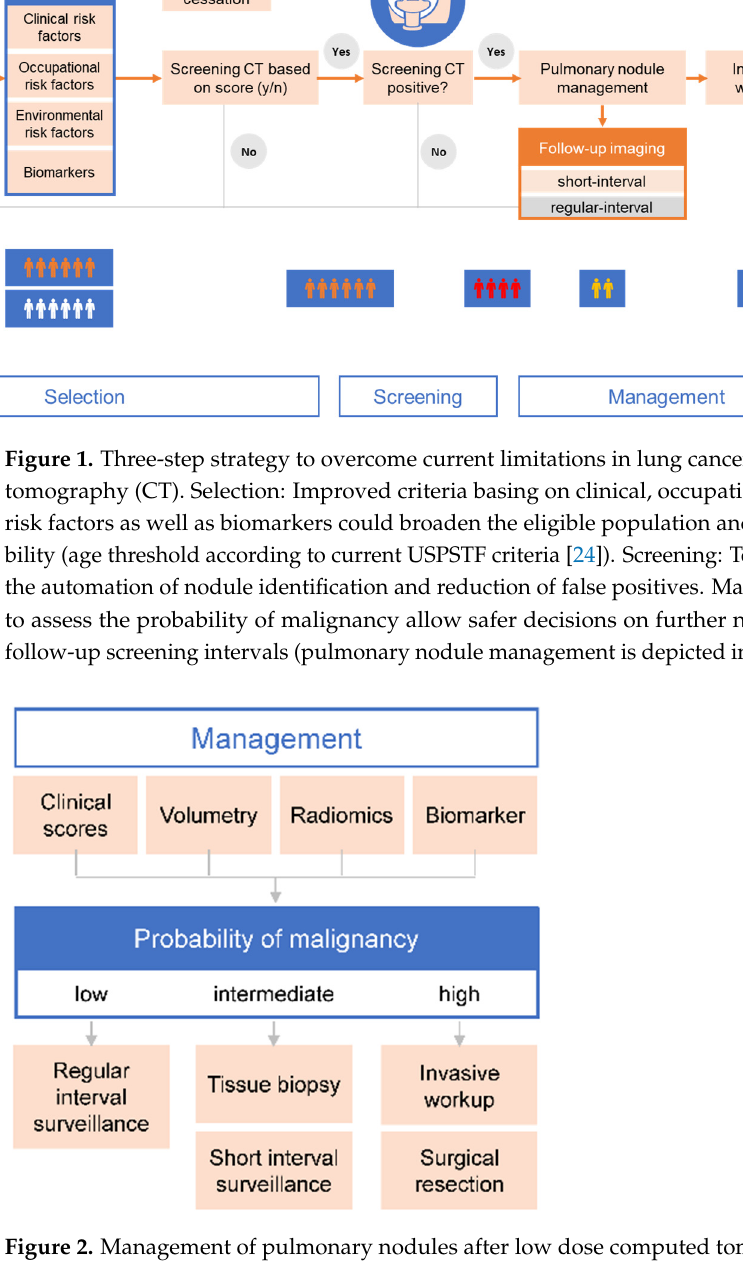
Figure 2. Management of pulmonary nodules after low dose computed tomography scanning.